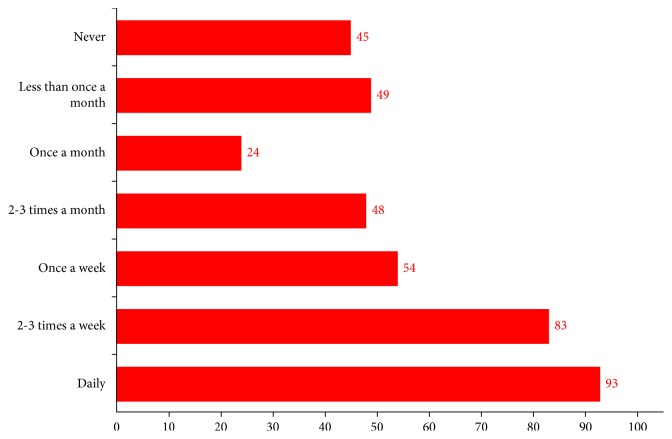
Frequency of use.